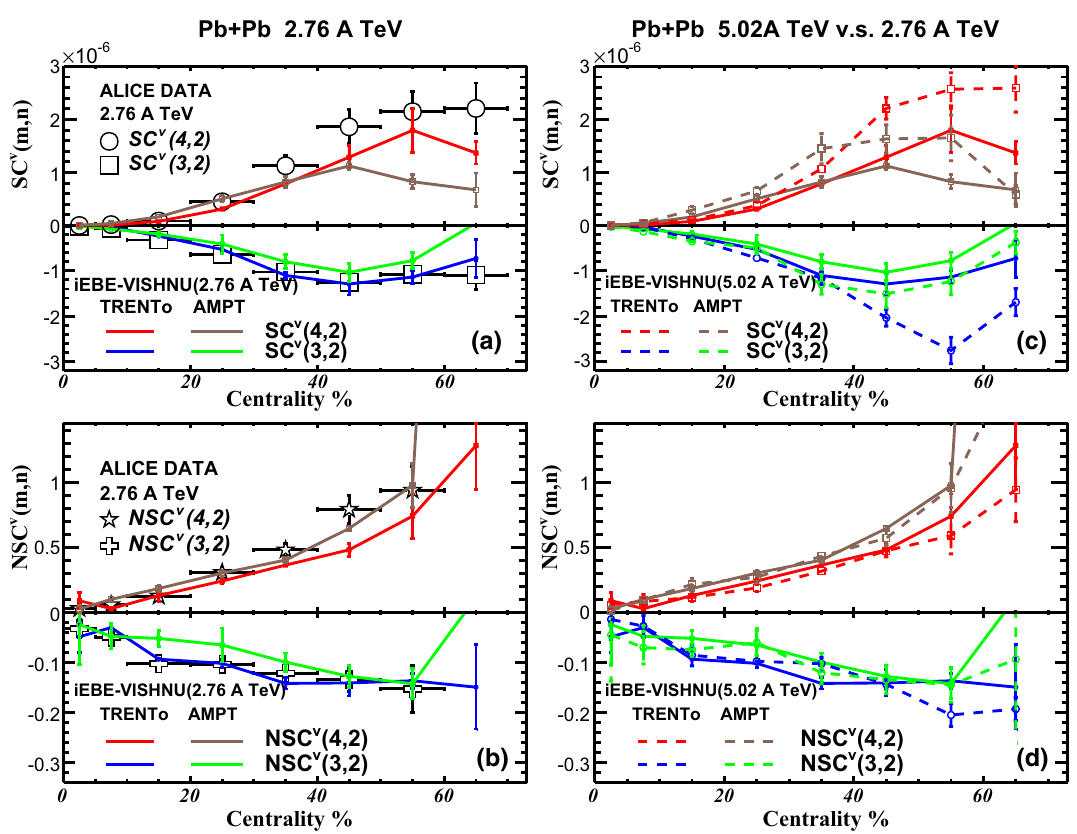
Fig. 9 Symmetric cumulants SC v ( m , n ) and normalized symmetric cumulants NSC v ( m , n ) in 2.76 and 5.02 A TeV Pb + Pb collisions, cal- culated from iEBE-VISHNU with TRENTo and AMPT initial condi-